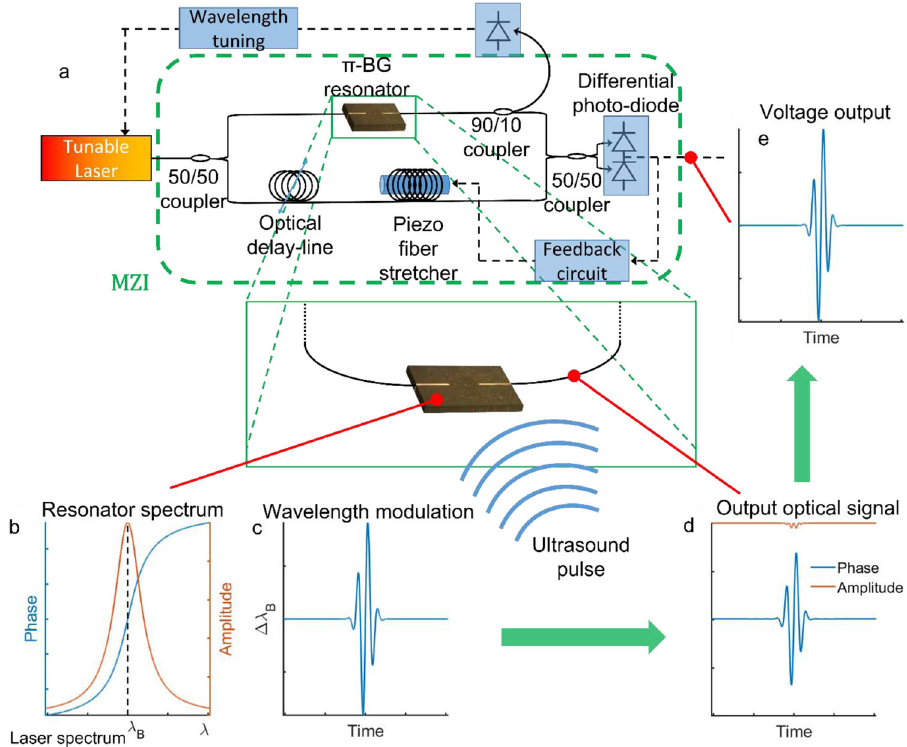
Fig. 3 Optical interrogation and readout system. a Illustration of the optical readout system. The plots show the resonator ’ s spectrum ( b ), ultrasound- induced wavelength modulation ( c ), and the corresponding optical output of the resonator ( d ). e The corresponding differential voltage signal, sampled at the output of the system. π -BG is π -phase-shifted Bragg